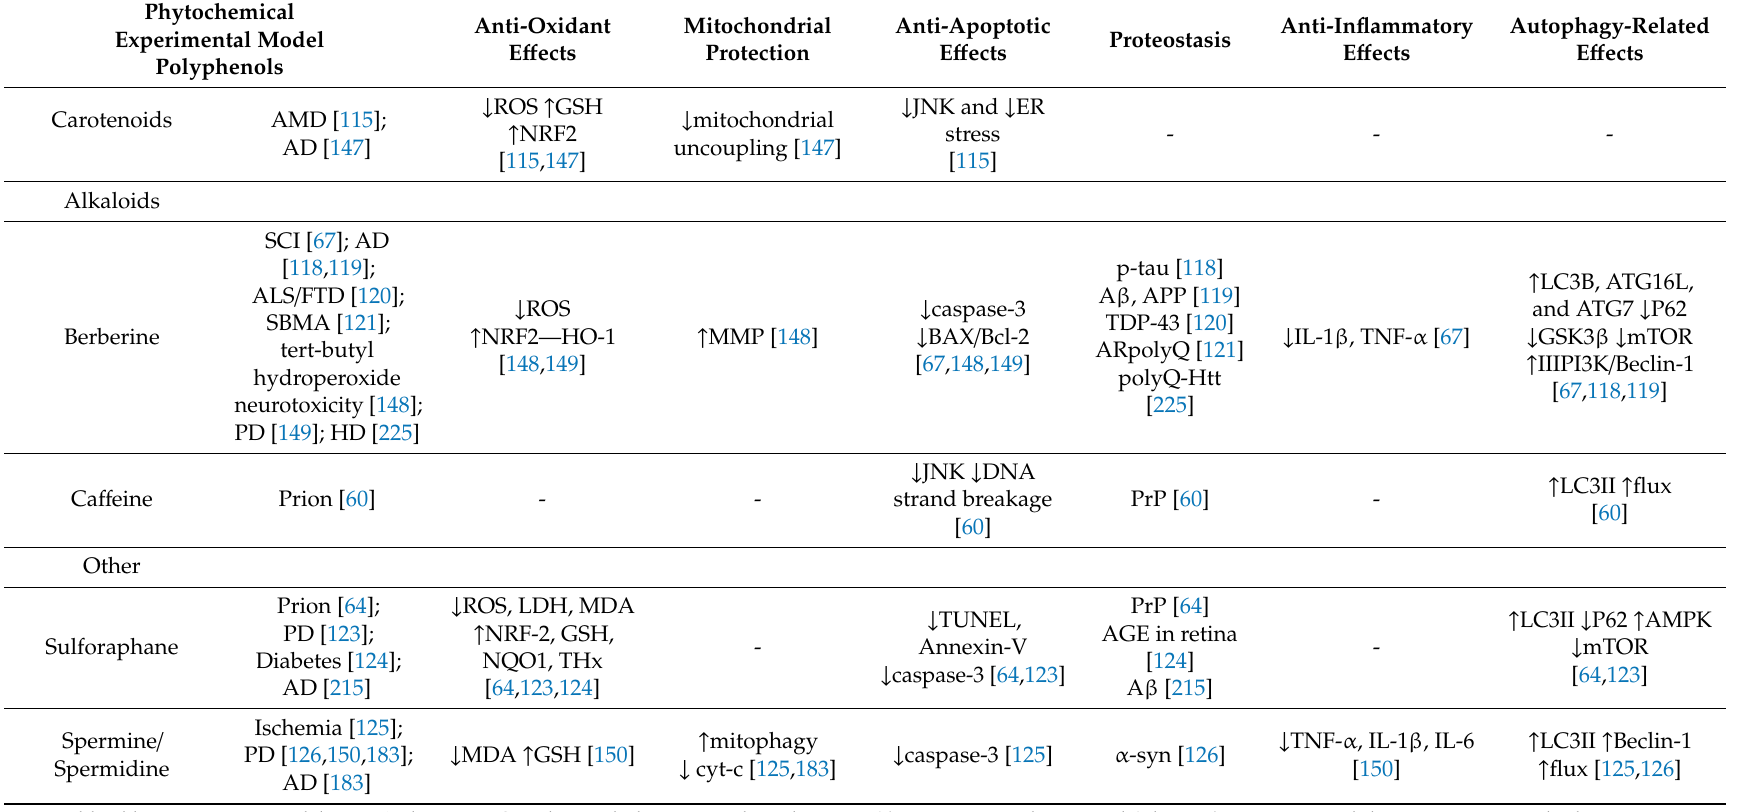
Table abbreviations. AD Alzheimer’s disease; AGE advanced glycation end products; ALS / FTD Amyotrophic Lateral Sclerosis / Frontotemporal dementia; APP amyloid precursor protein; ARpolyQ polyglutamine-expanded androgen receptor; CAT catalase; CHOP CCAAT-enhancer-binding protein homologous protein; COX-2 cycloxygenase-2; GFAP